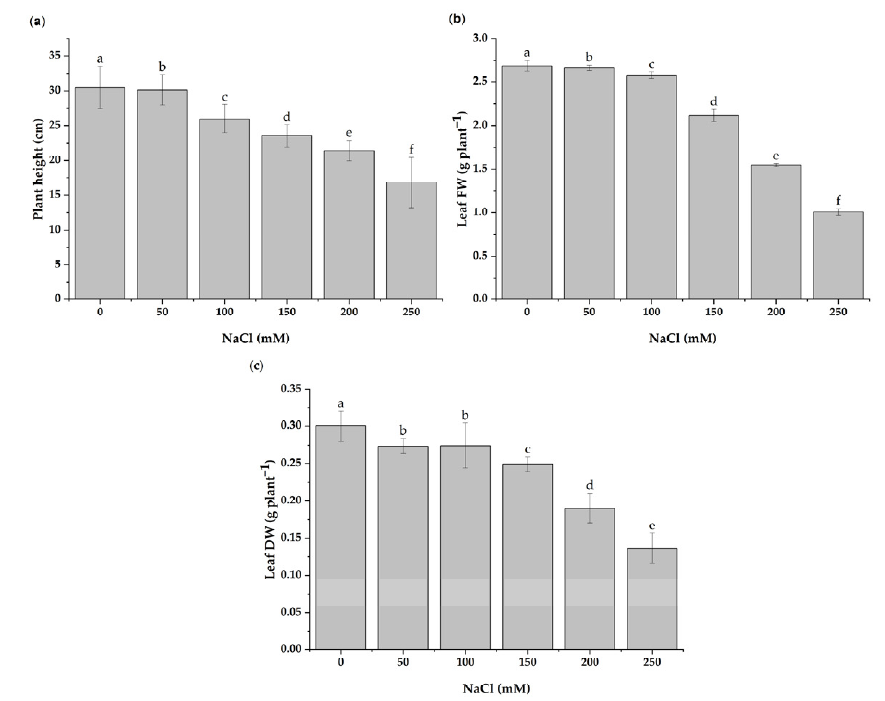
Figure 2. Effects of different levels of salinity stress (0, 50, 100, 150, 200, and 250 mM of NaCl) on the plant height ( a ) and fresh weight (FW) ( b ) and dry weight (DW) ( c ) of H. cannabinus leaves. The results are expressed in cm or g plant-1, as the means ± SD of different measurements ( n = 15). Means followed by a different letter within a column indicate a significant difference ( p < 0.05) based on Duncan’s multiple range test.